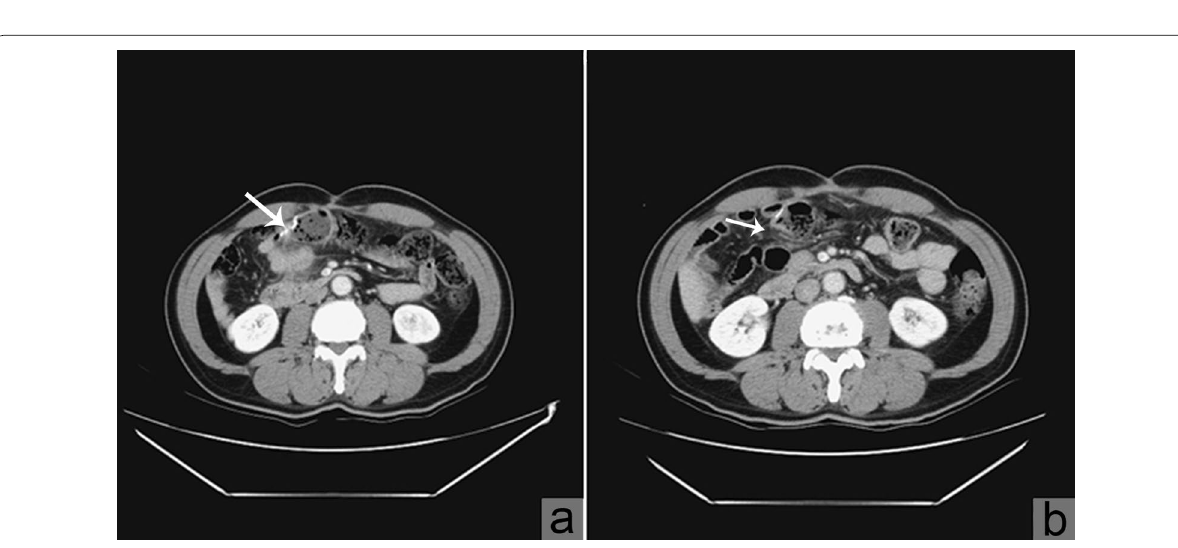
Fig. 2 Contrast‑enhanced abdominal CT study showed a a moderate contrast enhancement with apparent desmoplastic reaction near previous surgical sutures (white arrow); and b complete lesion clearance three months after surgery (white